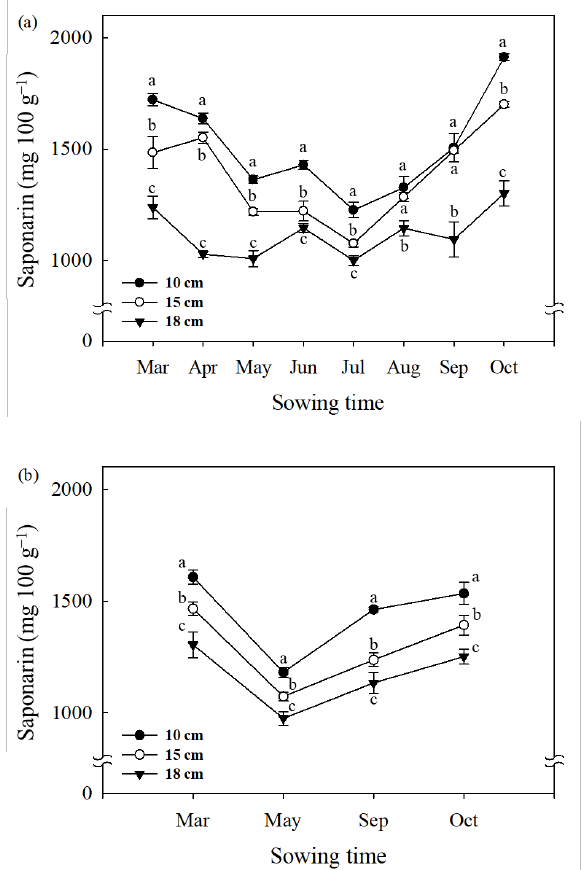
Figure 2. Change in saponarin content of barley sprouts (10, 15, and 18 cm length) grown at different sowing times in 2019 ( a ) and 2020 ( b ). Data represent mean ± standard deviation ( n = 3) and same letters in each sowing month indicate no significant difference in the saponarin content (Tukey’s HSD, p < 0.05).